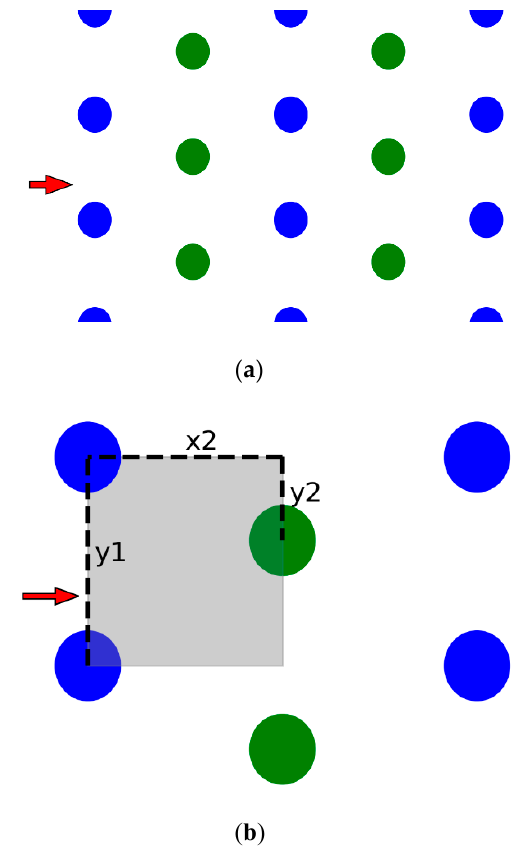
Figure 6. The picture ( a ) is schematic diagram of VAWT array unit, the picture ( b ) is zoom-in view. The red arrow indicates the inflow direction. Odd and even columns are arranged in the staggered arrangement. Blue circles represent the VAWTs in the odd column. Green circles represent the VAWTs in the even column. All VAWTs are rotating anticlockwise. There are three distance parameters ( y 1, x 2, y 2) of the array. Symbol y 1 represents the lateral distance between two turbines. Symbol x 2 represents the streamwise distance between two columns. Symbol y 2 represents the staggered distance between two columns, and y 2 < y 1 is satisfied. The gray region is defined as the unit area, which is y 1 × x 2.